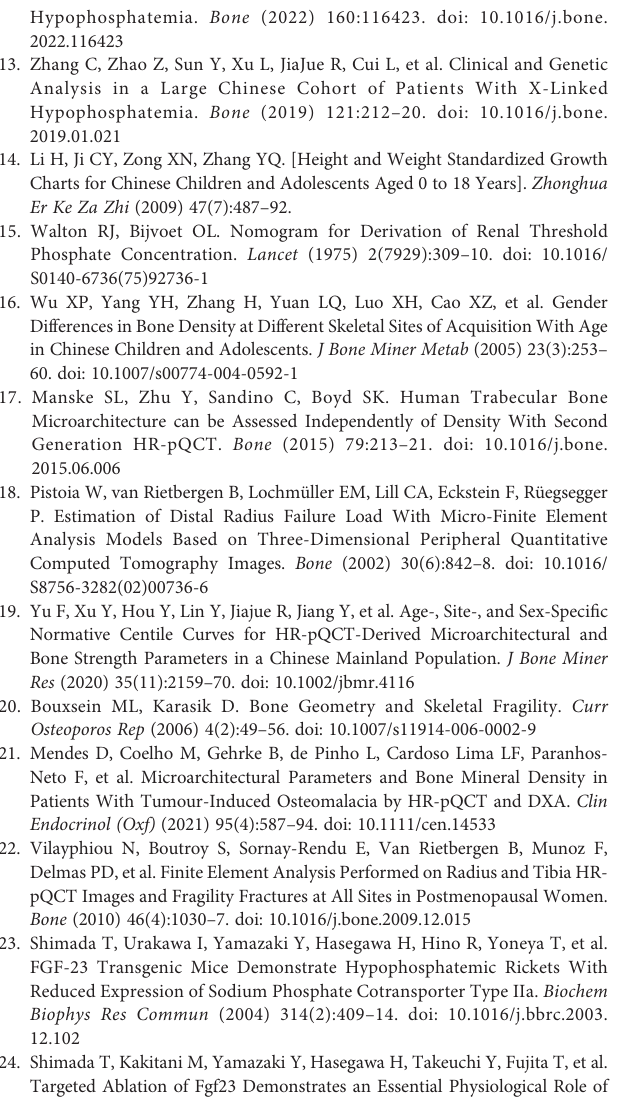
Supplementary Figure 1 | Percentage differences of the mean or median high- resolution peripheral quantitative computed tomography parameters in Chinese adolescents. (A) TIR/O versus XLH using the XLH group as the reference group. ( B ) TIR/Oversushealthycontrolusingthehealthycontrolgroupasthereferencegroup. (C) XLH versus healthy control using the healthy control group as the reference group. TIR/O, tumor-induced rickets/osteomalacia; XLH, X-linked